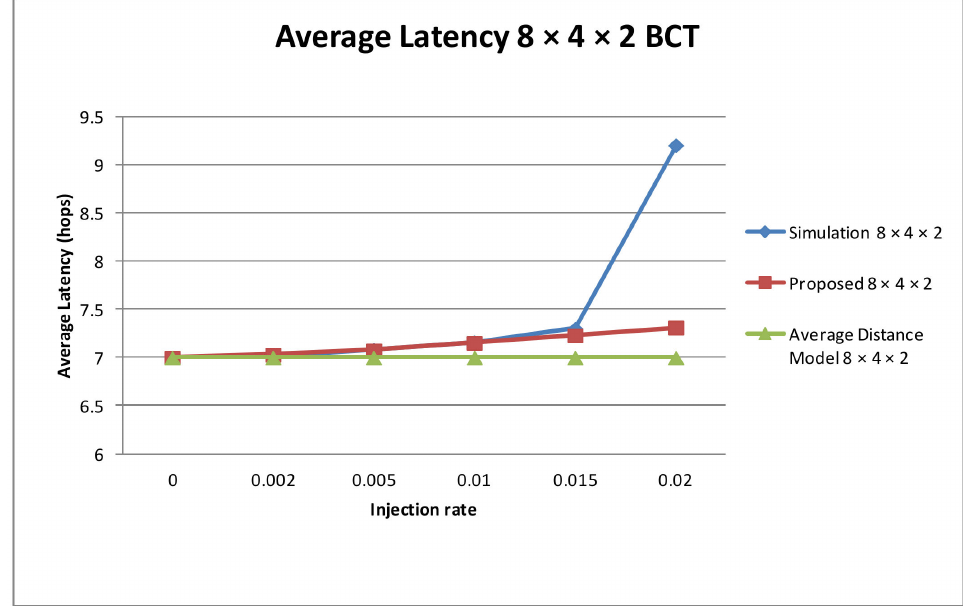
Figure 9. Average estimated latency vs. flit injection rate comparison between simulation, the proposed model and the average distance model for a 4 × 4 × 4 NoC topology and bit-complement